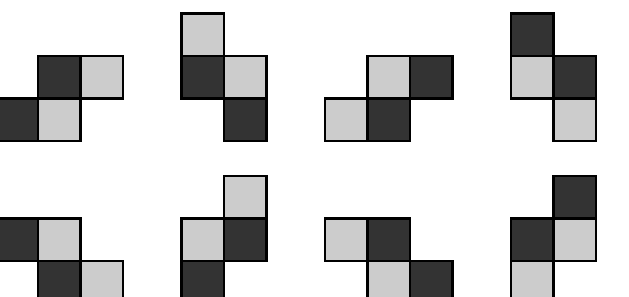
( = P − ) corresponding to the tetromino P i i i